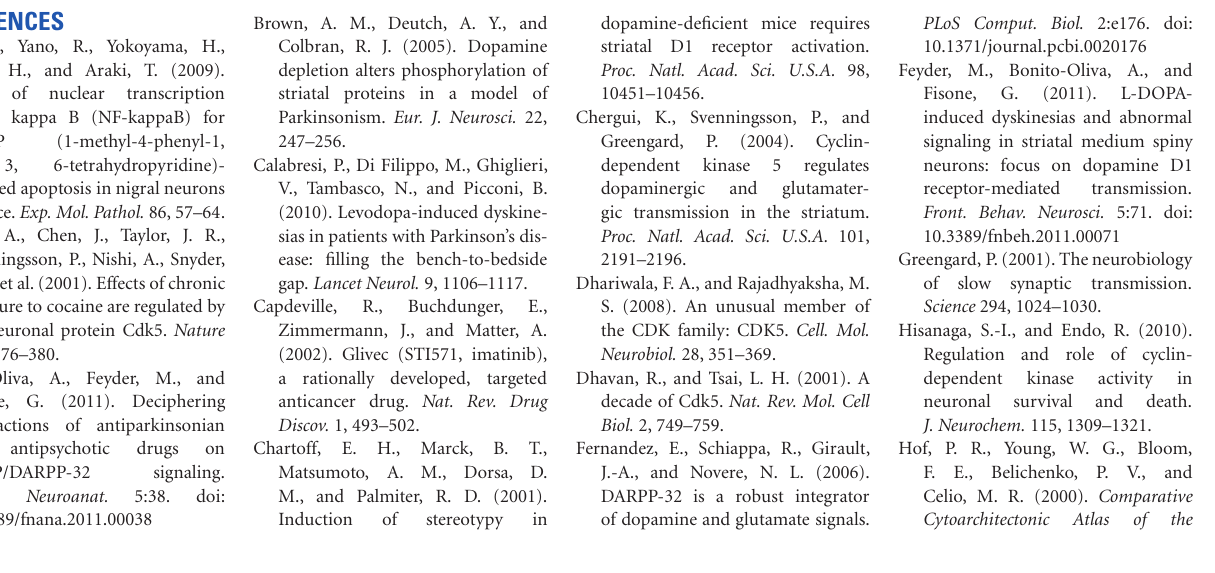
would be important in considering the pathophysiology of